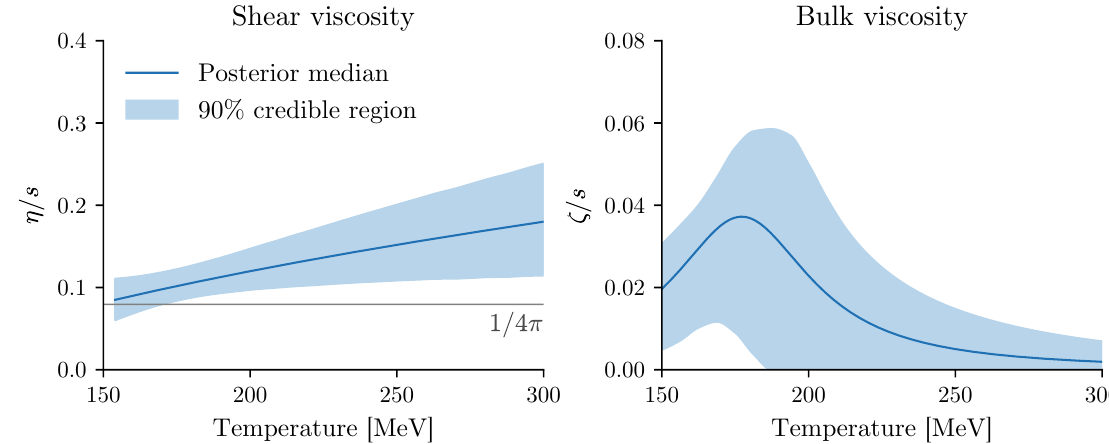
Figure 8. Estimated temperature dependence of the specific shear and bulk viscosity in Pb–Pb, ( η / s )( T ) and ( ζ / s )( T ) ; shaded regions are 90% credible regions. Figure taken from